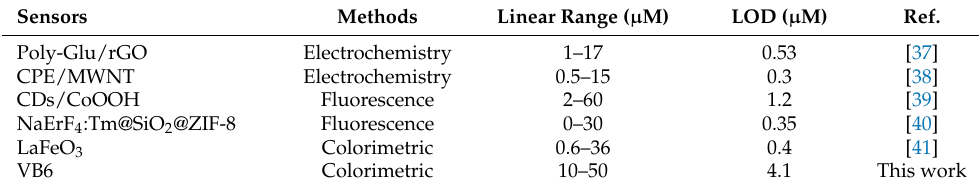
Table 2. Comparisons of determination of gallic acid based on different peroxidase mimics.